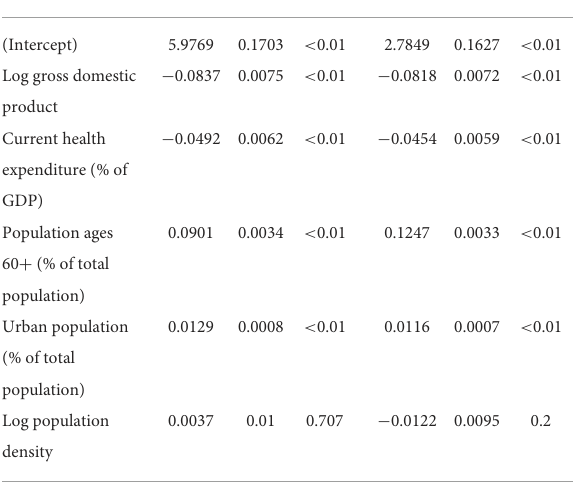
TABLE 2 Sociodemographic factors associated with DALYs and death rates of